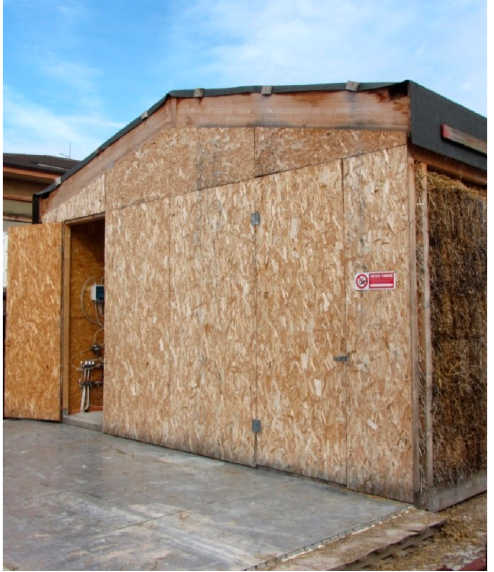
Figure 1. The south-west façade of the monitored building.